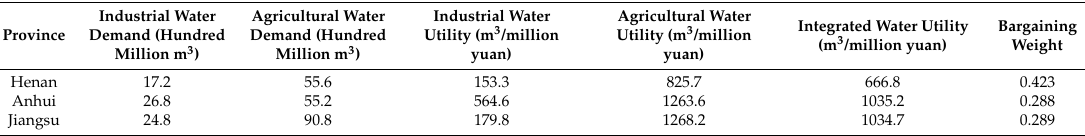
Table 5. The bargaining weights under the efficiency